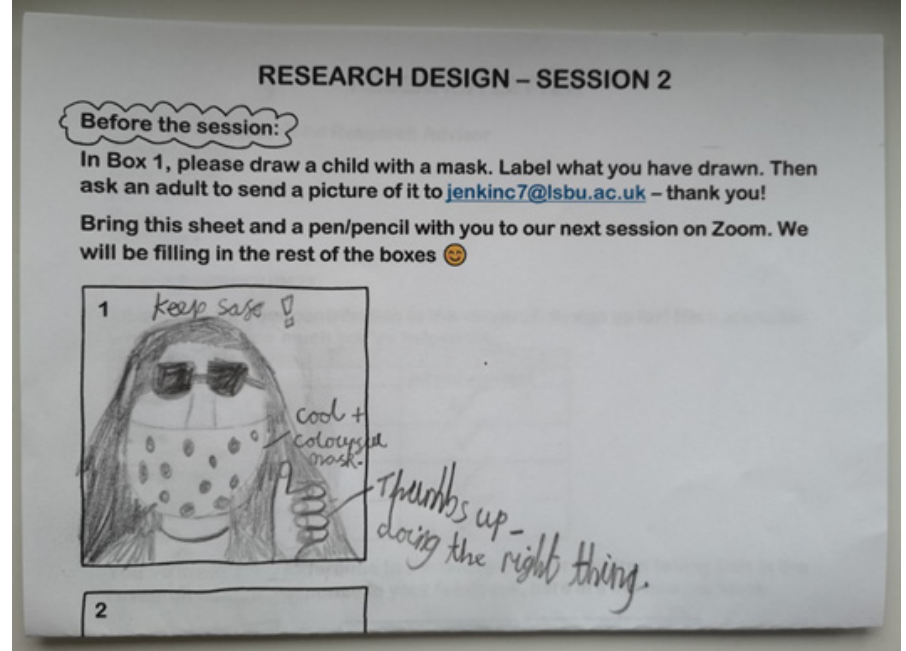
Figure 3. Example of a Child Advisor’s pre-consultation ‘drawing 1 ′ . The labels read: ‘keep safe!/cool + colourful mask’/‘Thumbs up–doing the right thing’.